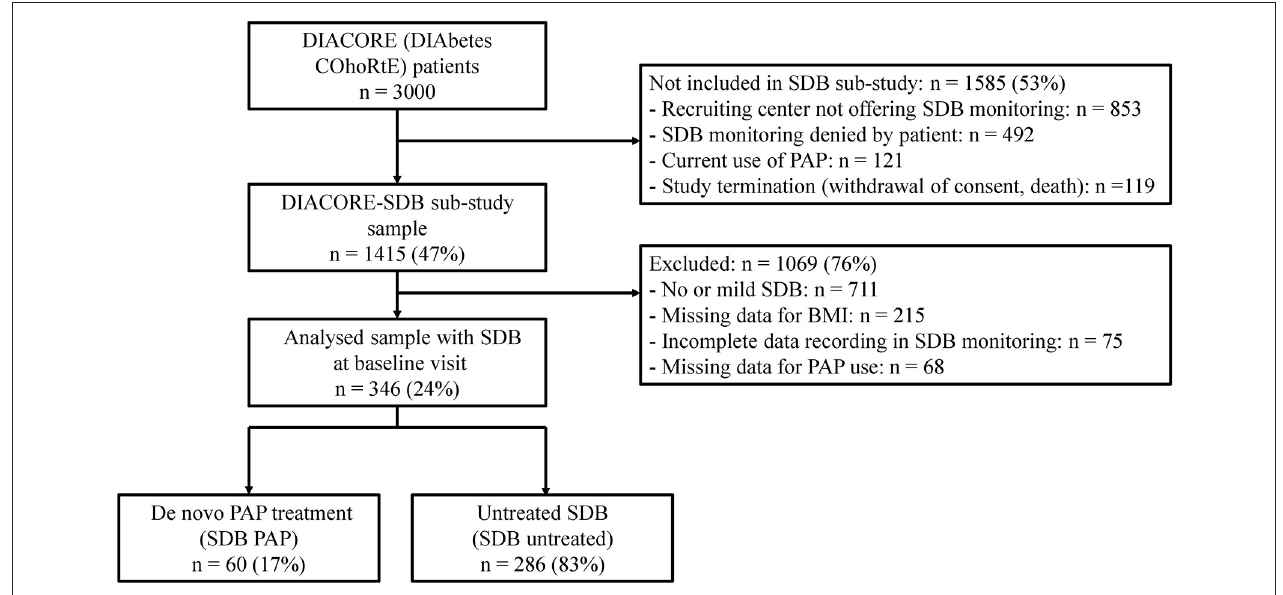
FIGURE 1 | Study flow chart. BMI, body-mass index; PAP, positive airway pressure; SDB, sleep-disordered